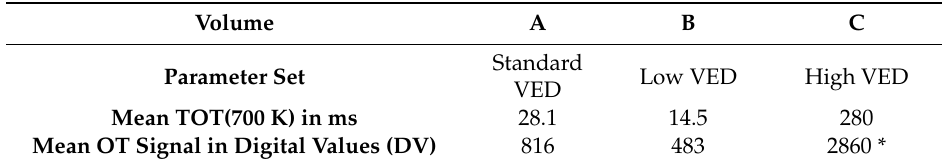
Table 4. Mean values of the in-situ measurement results for the volumes with di ff erent energy density settings. The mean values were calculated for areas well within the respective volumes in order to avoid the influence of edge e ff